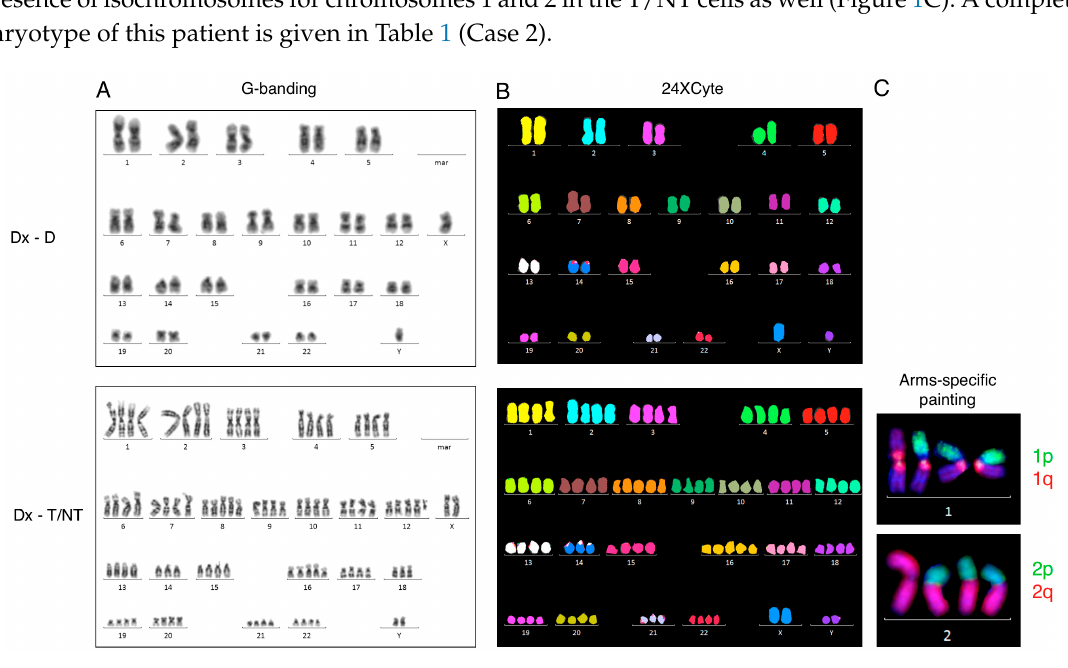
Figure 1. G-banding, 24-color karyotyping, and arms-specific chromosome painting. ( A ) G-banded karyotype at diagnosis showing a normal diploid karyotype (upper panel, Dx-D) and a near-tetraploid karyotype (lower panel, Dx-T/NT). ( B ) 24-color karyotyping at diagnosis showing a normal diploid karyotype (upper panel) and a near-tetraploid karyotype (lower panel). ( C ) A partial karyotype of near-tetraploid cells after arms-specific chromosome painting with 1p and 1q probes (upper panel) and with 2p and 2q (lower panel). Dx-D is diploid scored cells at diagnosis, and Dx-T/NT is tetraploid/near-tetraploid scored cells at